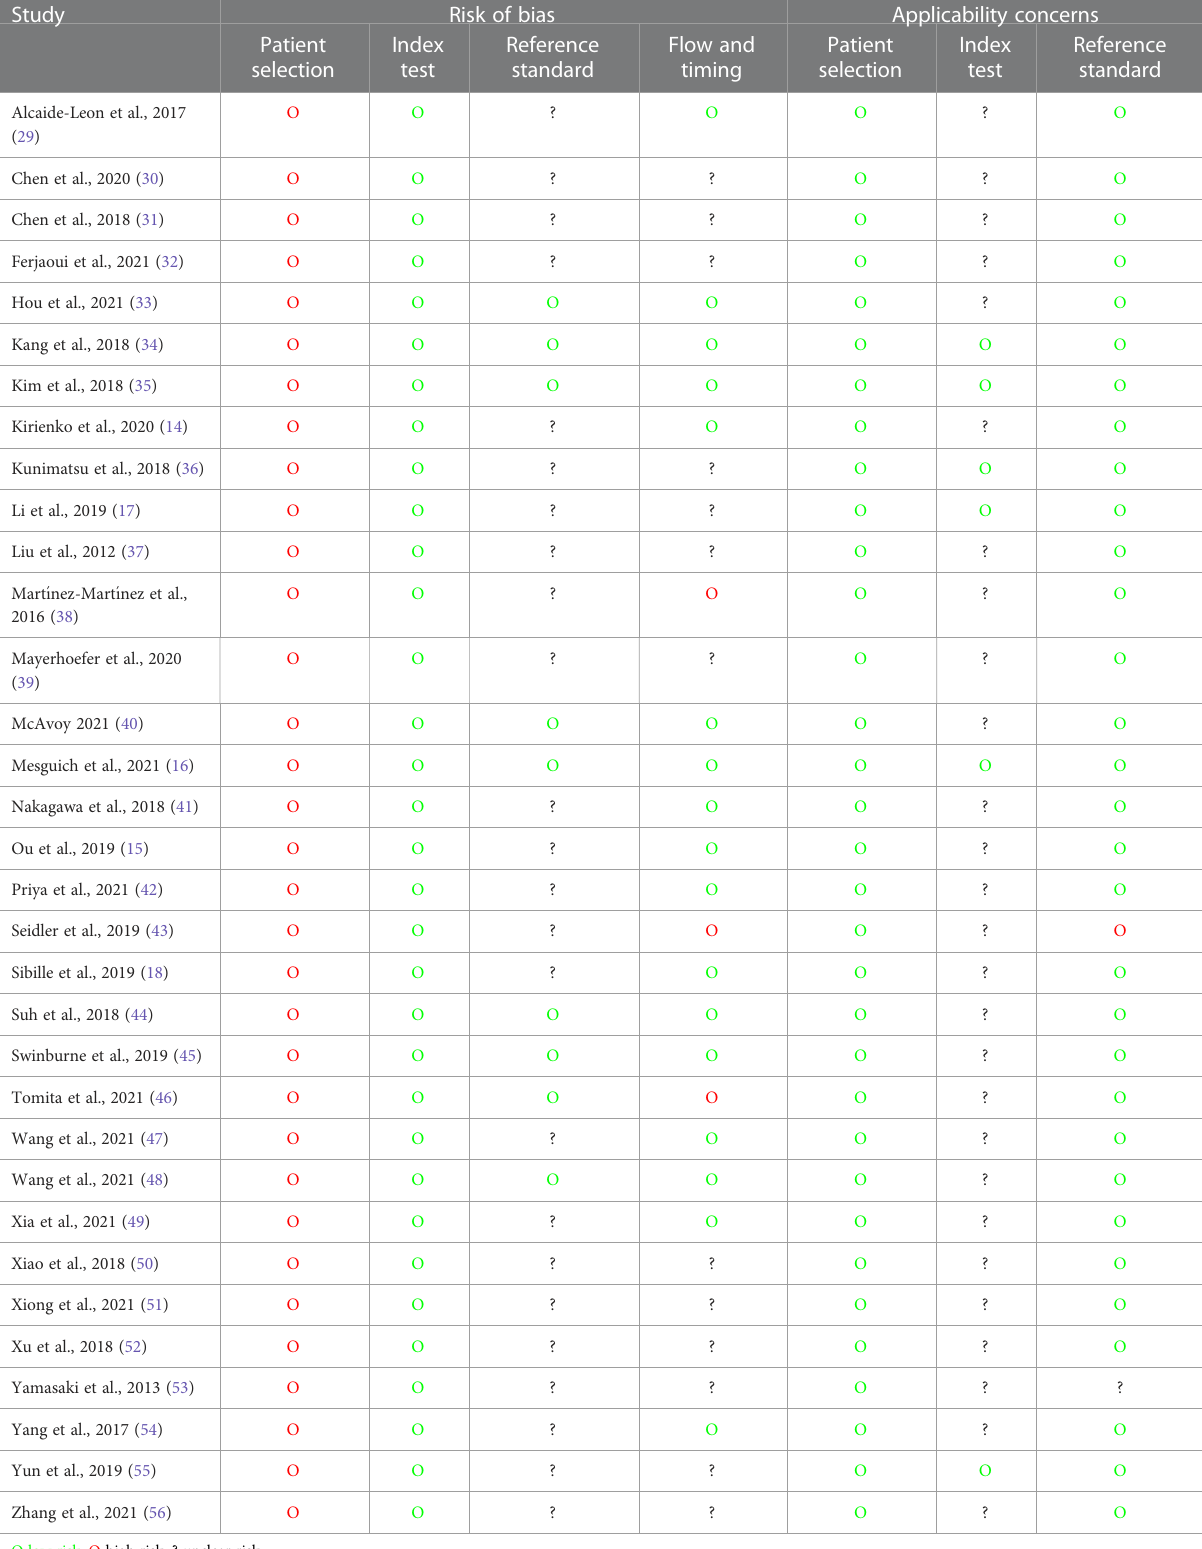
TABLE 4 Quality Assessment of Diagnostic Accuracy Studies 2 (QUADAS-2) assessment for diagnostic